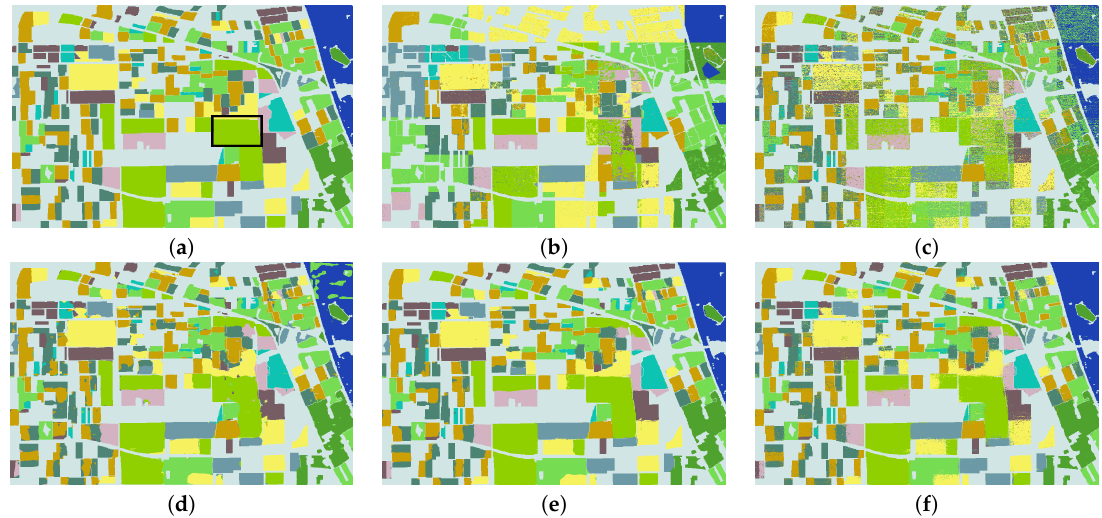
Figure 10. Visual classification of different algorithms on Flevoland dataset. ( a ) GT. ( b ) T3: 54.10%. ( c ) TSNE: 70.92%. ( d ) FCN: 93.58%. ( e ) T3-FCN: 96.76%. ( f ) TSNE-FCN: 94.48%.